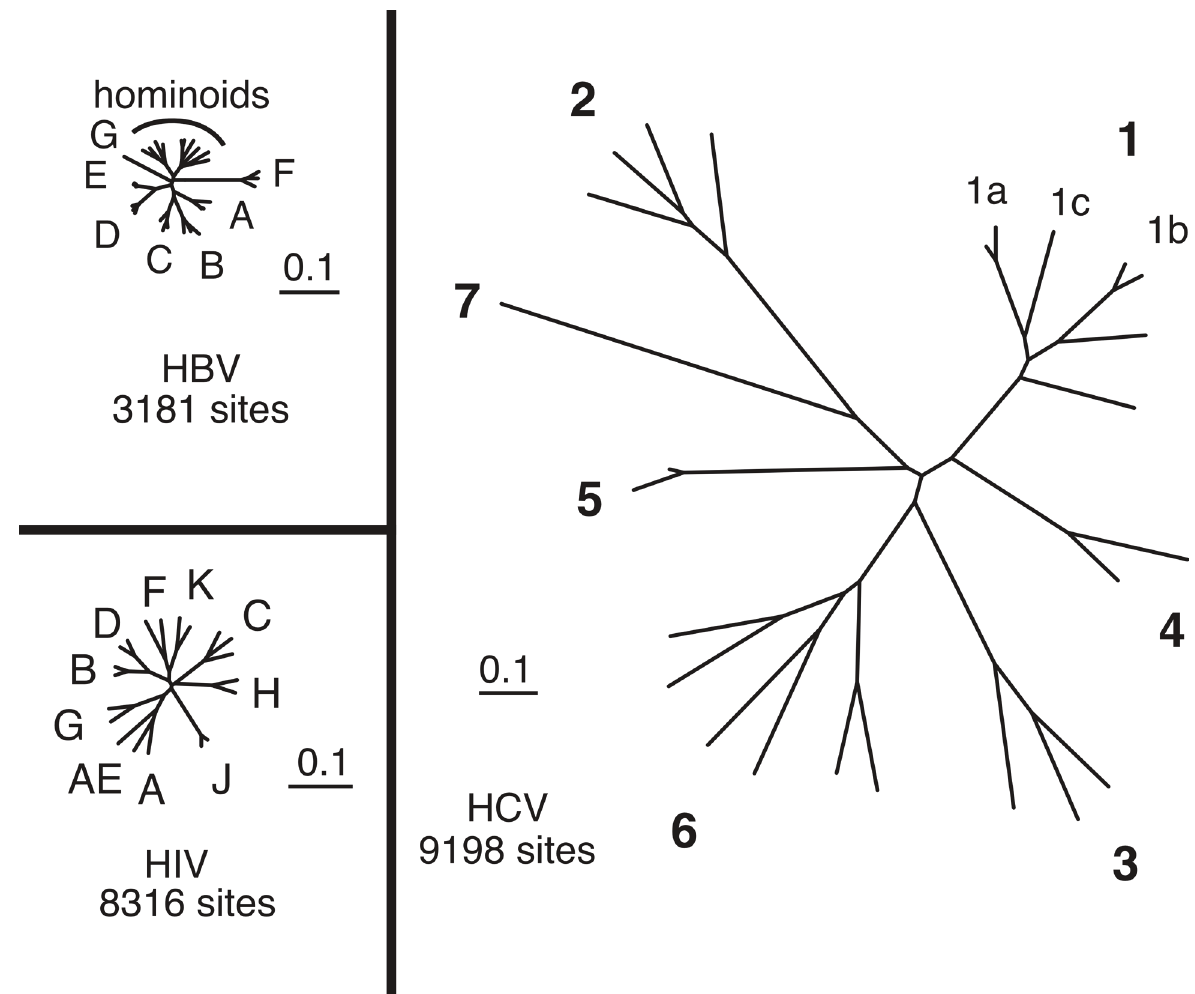
Figure 4: Viral diversity of three viruses: HIV, HBV amnd HCV. Phylogenetic trees for hepatitis B virus (HBV), human immunodeficiency virus (HIV), and hepatitis C virus (HCV) shown to the same scale in terms of nucleotide genetic distance, based on full-length genome nucleotide sequences.Sequences of representative strains for major genotypes were obtained from GenBank and aligned using ClustalX with minor manual adjustment, and then sites containing gaps were removed, resulting in an alignment of 3181 sites for HBV, 8316 sites for HIV, and 9198 sites for HCV. Maximum likelihood trees were inferred using PAUP* version 4b10, with the model (GTR+I+G in all three cases) and parameters selected by ModelTest 3.7 using the AIC